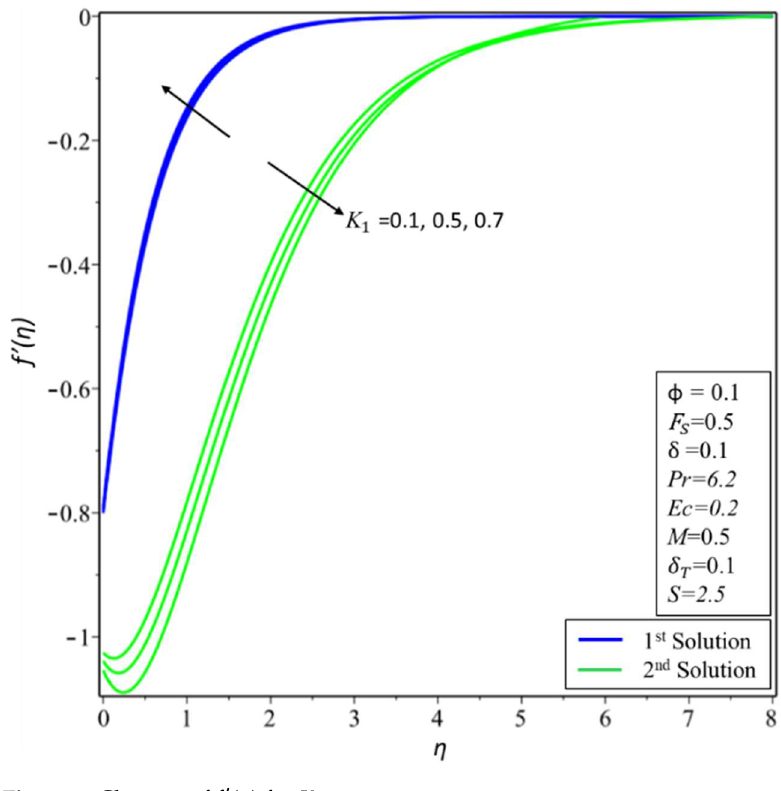
Figure 6. Changes of 𝑓′(𝜂) for 𝐾 (cid:2869) .